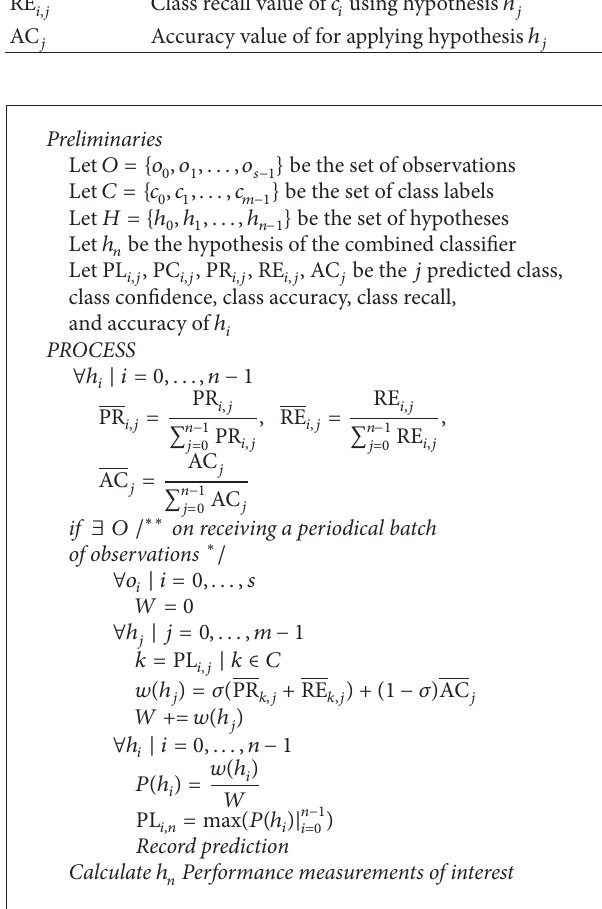
Algorithm 1: Noise-aware signal combination